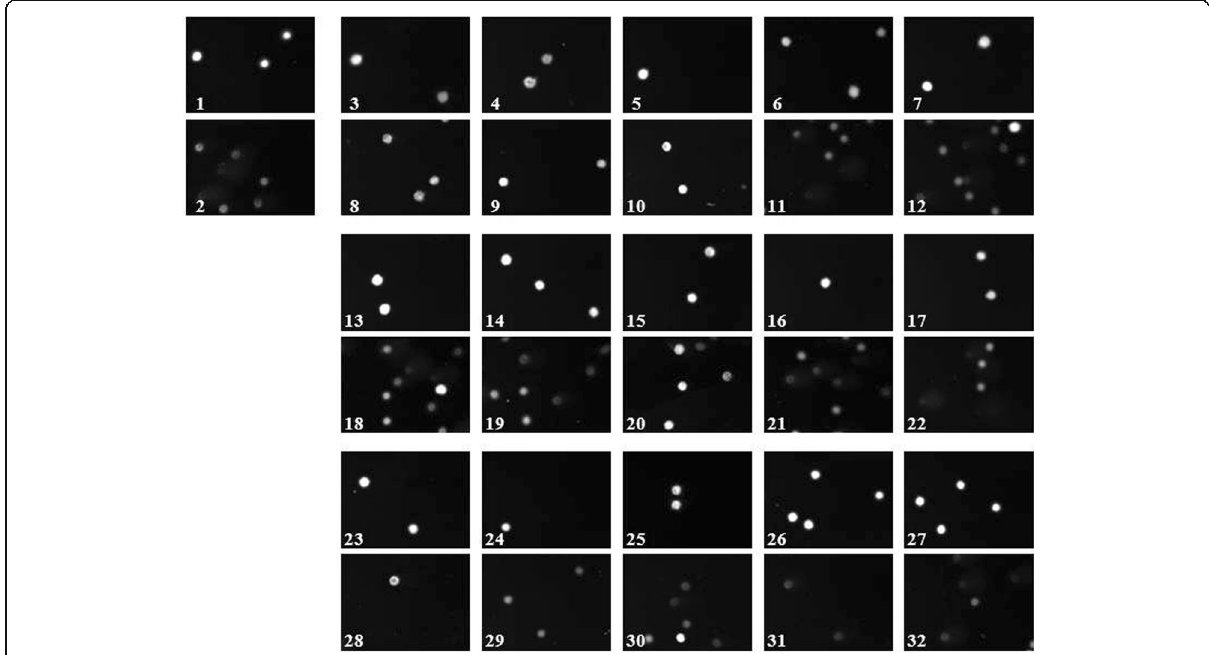
Fig. 5 The images of cells for each treatment in comet assay. (1) Negative control (0.5% DMSO); (2) positive control (100 μ M H 2 O 2 ). (3) 1 μ g/mL of catechins; (4) 5 μ g/mL of catechins; (5) 25 μ g/mL of catechins; (6) 50 μ g/mL of catechins; (7) 100 μ g/mL of catechins; (8) 1 μ g/mL of catechins + H 2 O 2 ; (9) 5 μ g/mL of catechins + H 2 O 2 ; (10) 25 μ g/mL of catechins + H 2 O 2 ; (11) 50 μ g/mL of catechins + H 2 O 2 ; (12) 100 μ g/mL of catechins + H 2 O 2 ; (13) 1 μ g/mL of gallocatechin; (14) 5 μ g/mL of gallocatechin; (15) 25 μ g/mL of gallocatechin; (16) 50 μ g/mL of gallocatechin; (17) 100 μ g/mL of gallocatechin; (18) 1 μ g/mL of gallocatechin + H 2 O 2 ; (19) 5 μ g/mL of gallocatechin + H 2 O 2 ; (20) 25 μ g/mL of gallocatechin + H 2 O 2 ; (21) 50 μ g/mL of gallocatechin + H 2 O 2 ; (22) 100 μ g/mL of gallocatechin + H 2 O 2 ; (23) 1 μ g/mL of rutin; (24) 5 μ g/mL of rutin; (25) 25 μ g/mL of rutin; (26) 50 μ g/mL of rutin; (27) 100 μ g/mL of rutin; (28) 1 μ g/mL of rutin + H 2 O 2 ; (29) 5 μ g/mL of rutin + H 2 O 2 ; (30) 25 μ g/mL of rutin + H 2 O 2 ; (31) 50 μ g/mL of rutin + H 2 O 2 ; (32) 100 μ g/mL of rutin + H 2 O